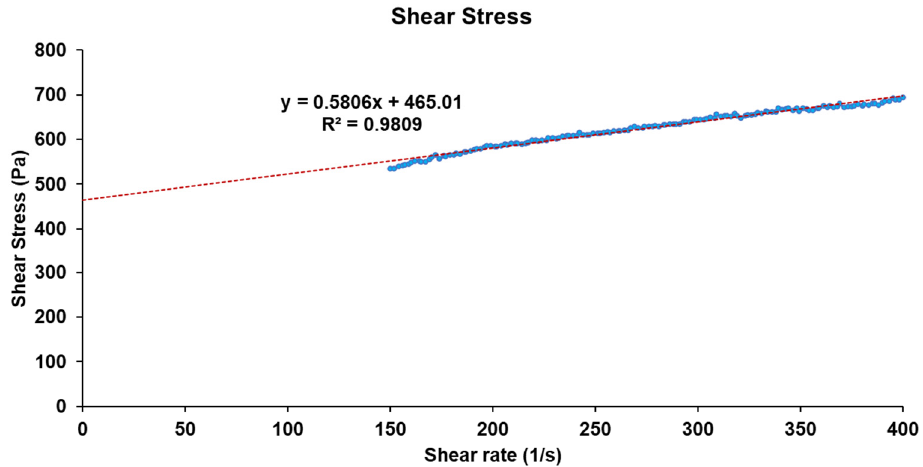
Figure 9. Linear tract of the curve of shear stress vs. shear rate (Bingham plastic behavior). Dynamic viscosity is a constant corresponding to the slope of the equation (0.5806), while the intercept (465.01) corresponds to the yield stress.